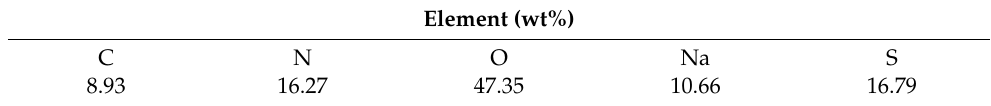
Figure 3. SEM image of CNCs prepared under a 1.5 M APS concentration at 70 ◦ C for 16 h. Table 1. Elements present in